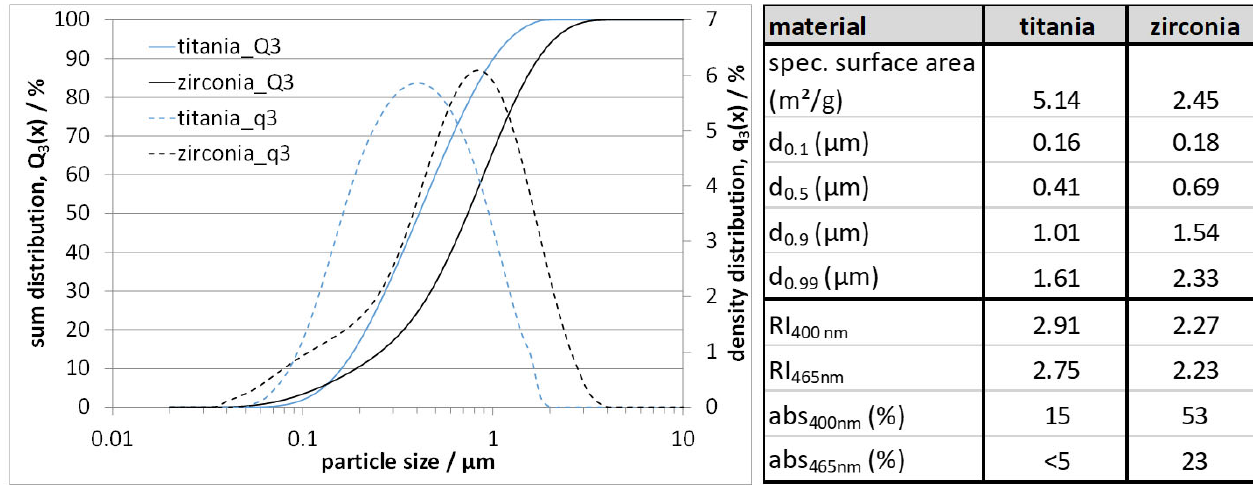
Figure 3. Particle size distribution (sum distribution: Q 3 (x) and density distribution: q 3 (x)) of titania and zirconia raw material (left); table comparing the specific characteristic sizes and the specific surface area, where “d” denotes the diameter at a given permeate of an analytical mesh which has been formerly used for sieve analysis, i.e., 0.1 = 10% flux through a mesh, 0.9 = 90% flux through a mesh.